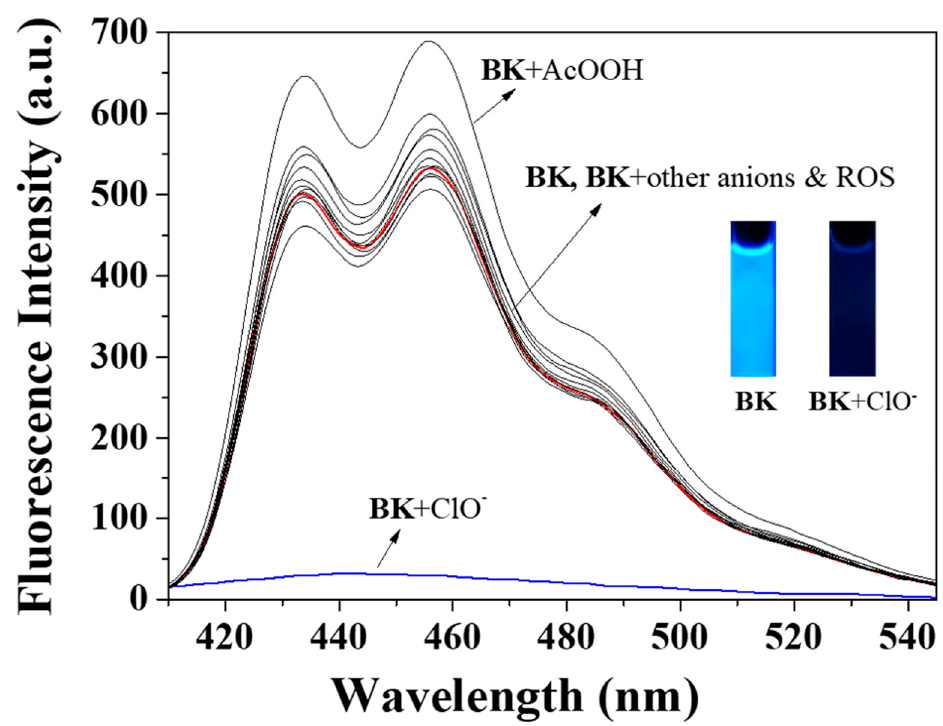
Figure 1. Fluorescence spectra of BK (1 × 10 − 5 M) with varied analytes (220 equiv). ROS: Reactive oxygen species.